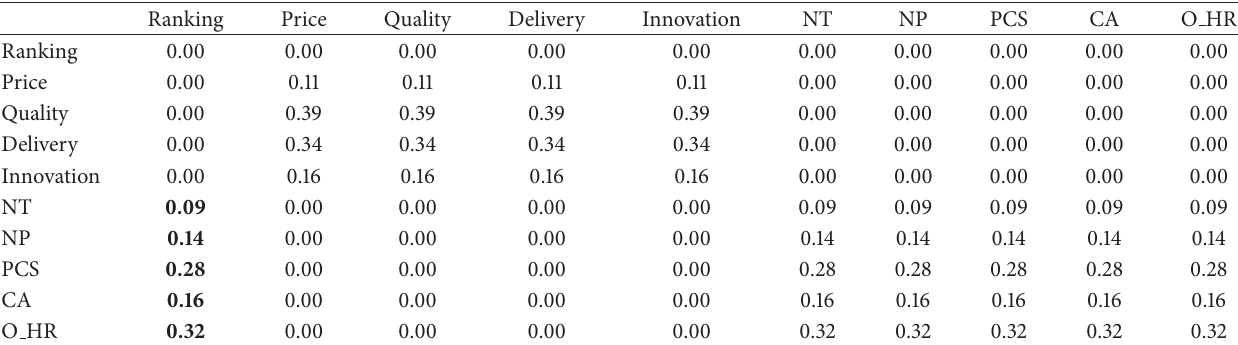
Table 15: Matrix limit corresponding to the harmonization of the decisions of the decision agents.